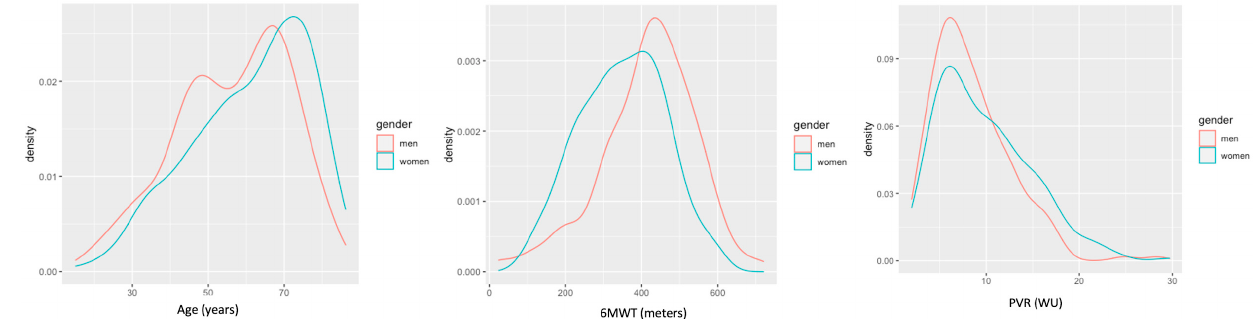
Figure 4. The distribution of relevant baseline characteristics in women and men. In the left panel, two peaks of a younger age can be seen for men. In the central panel, there is a homogeneous and higher distribution of the walked distance for men. In the right panel, there is also a more homogeneous and lower distribution of the PVR for men in comparison with a more heterogeneous and higher distribution of PVR among women. 6MWT (six-minute walking test), PVR (pulmonary vascular resistance), WU (Wood Units).